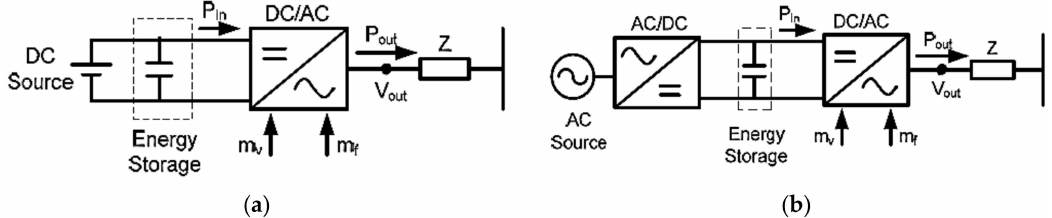
Figure 2. ( a ) Inverter for DC source. ( b ). Inverter for AC